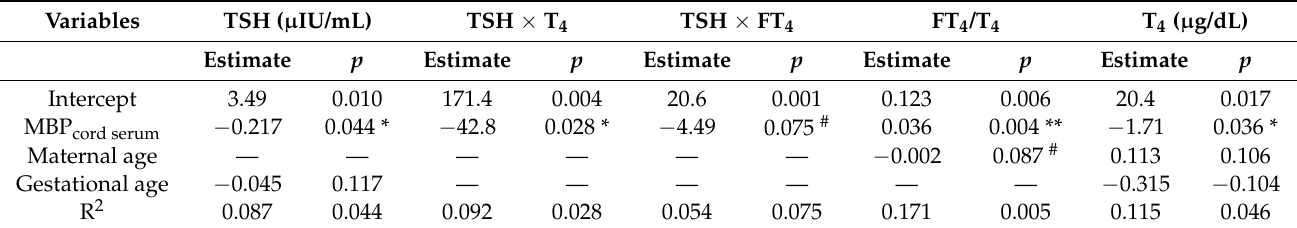
Table 5. Multiple linear regression between TSH and T 4 levels and their corresponding phthalate metabolites in cord serum ( n = 60) a .